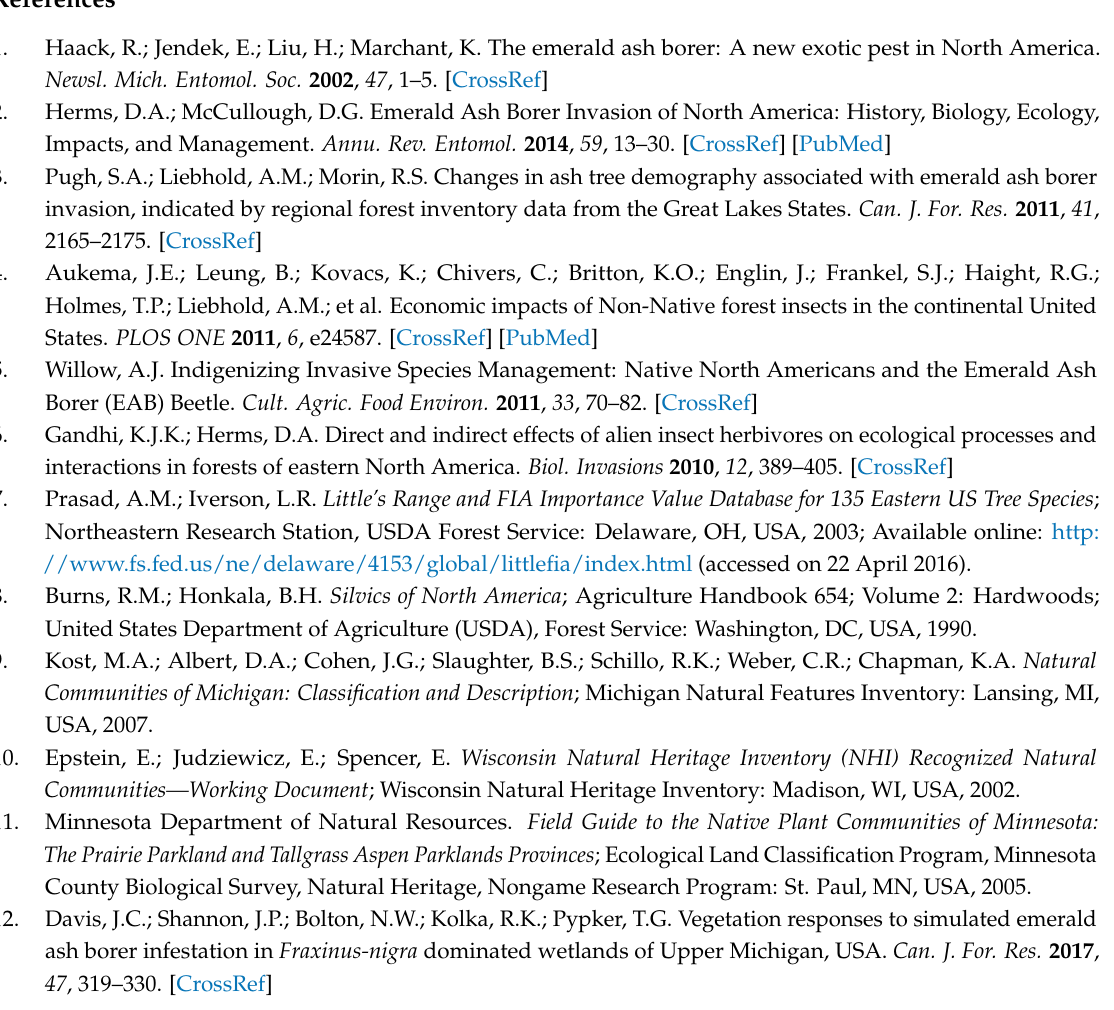
Table S1: Effect size, reported as Cohen’s d and exact Tukey-adjusted p -value (in parentheses) of pairwise comparisons among species within water level bins and among water level bins within species of estimated marginal means and slopes. Figure S1: Daily mean sap flux of individual probes by (A) daylight-normalized vapor-pressure deficit ( D z ) and (B) mean daily water level. Linear models with 95% prediction intervals fit individually for each